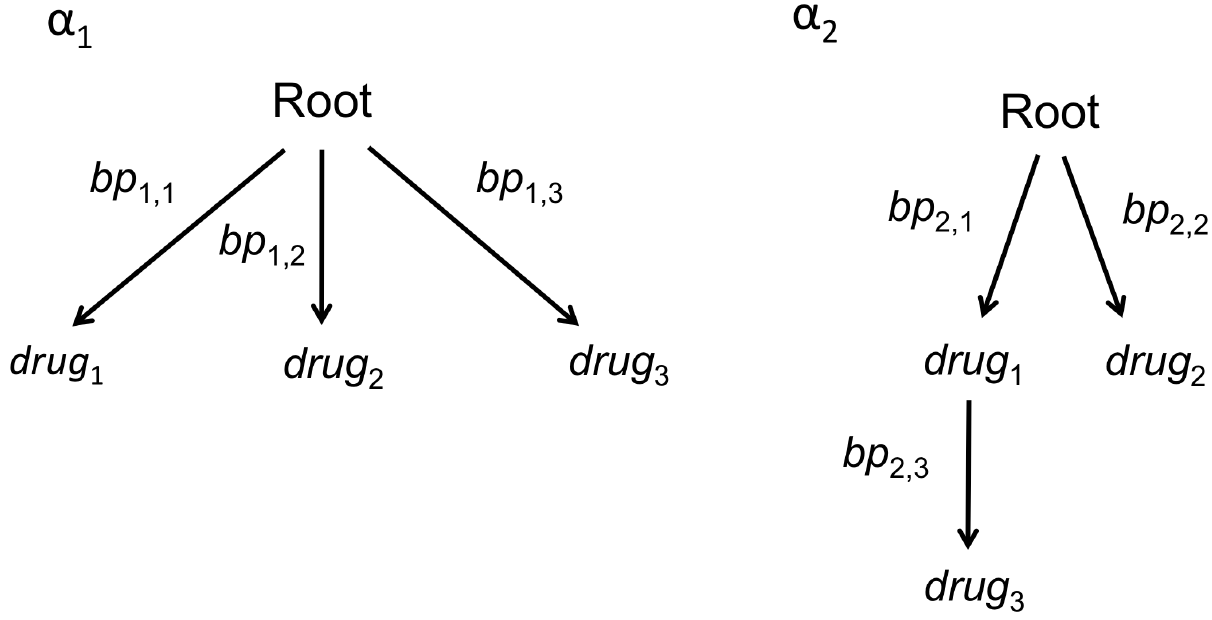
Figure 2. An example of the graphical display of a 2-tree mixture model with three nodes. bp is the set of edge weights defined as the conditional probability of the child node given the prior occurrence of the parent event. a 1 and a 2 are the probability that an individual follows a pathway represented by the first and second tree, respectively.